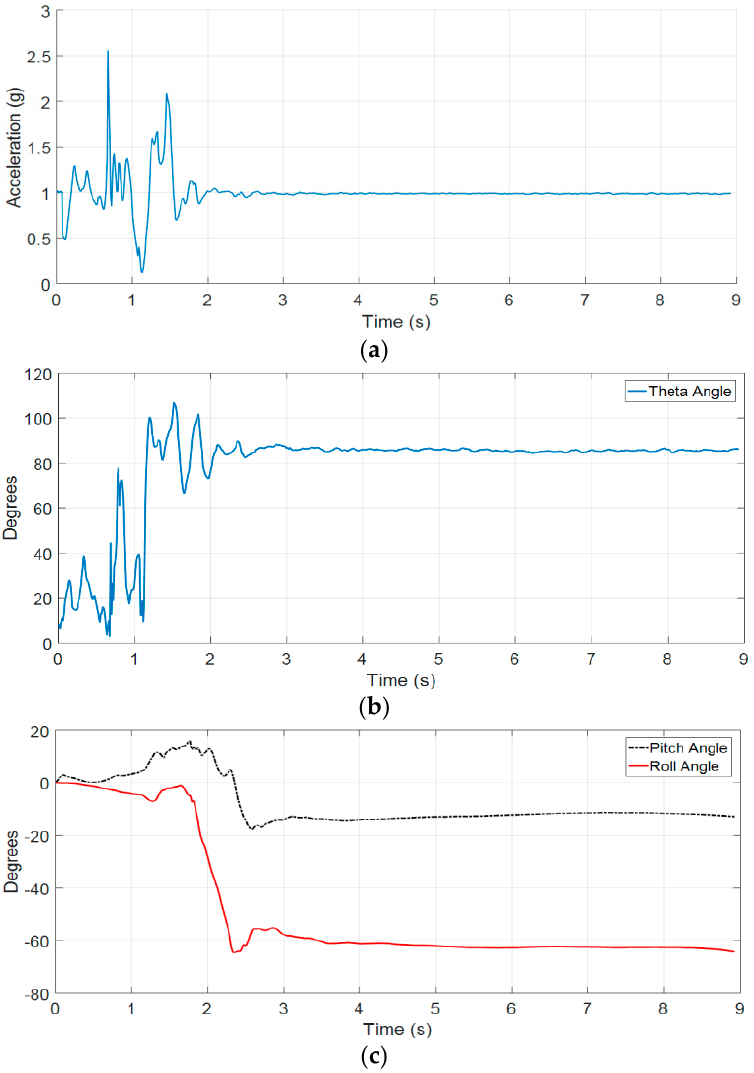
Figure 11. ( a ) The RMS of acceleration of a fall forward from standing, first impact on knees; ( b ) the theta angle; ( c ) the pitch and roll angles.